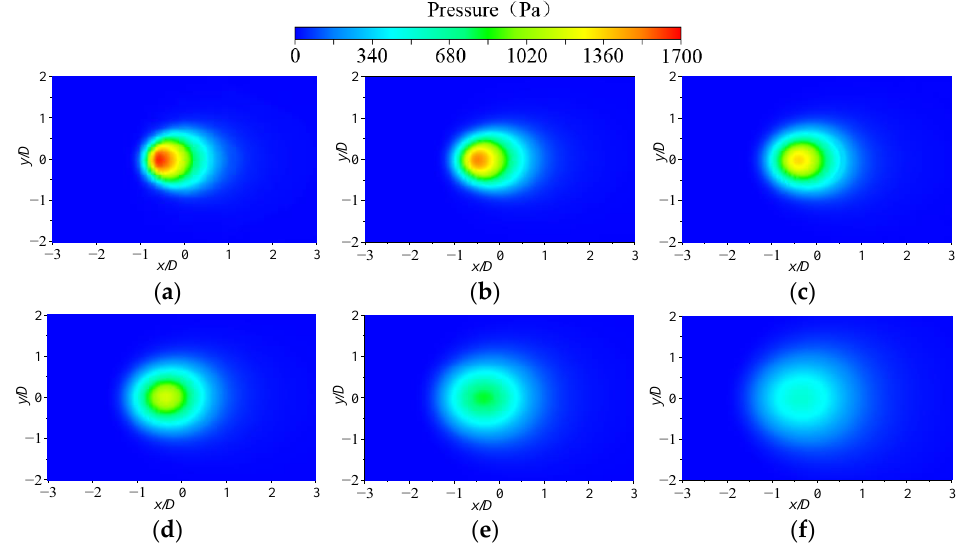
Figure 16. Pressure contour of jet impingement plane ( oxy plane) under various impinging heights: ( a ) H/D = 1; ( b ) H/D = 2; ( c ) H/D = 3; ( d ) H/D = 4; ( e ) H/D = 6; ( f ) H/D = 8.